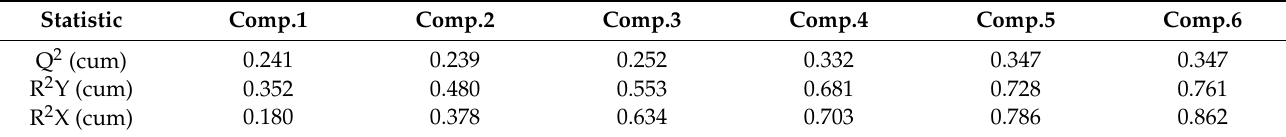
Table 2. Quality index (Q 2 , R 2 Y, and R 2 X) for partial least square regression on visual and gustatory sensory descriptors. Statistic